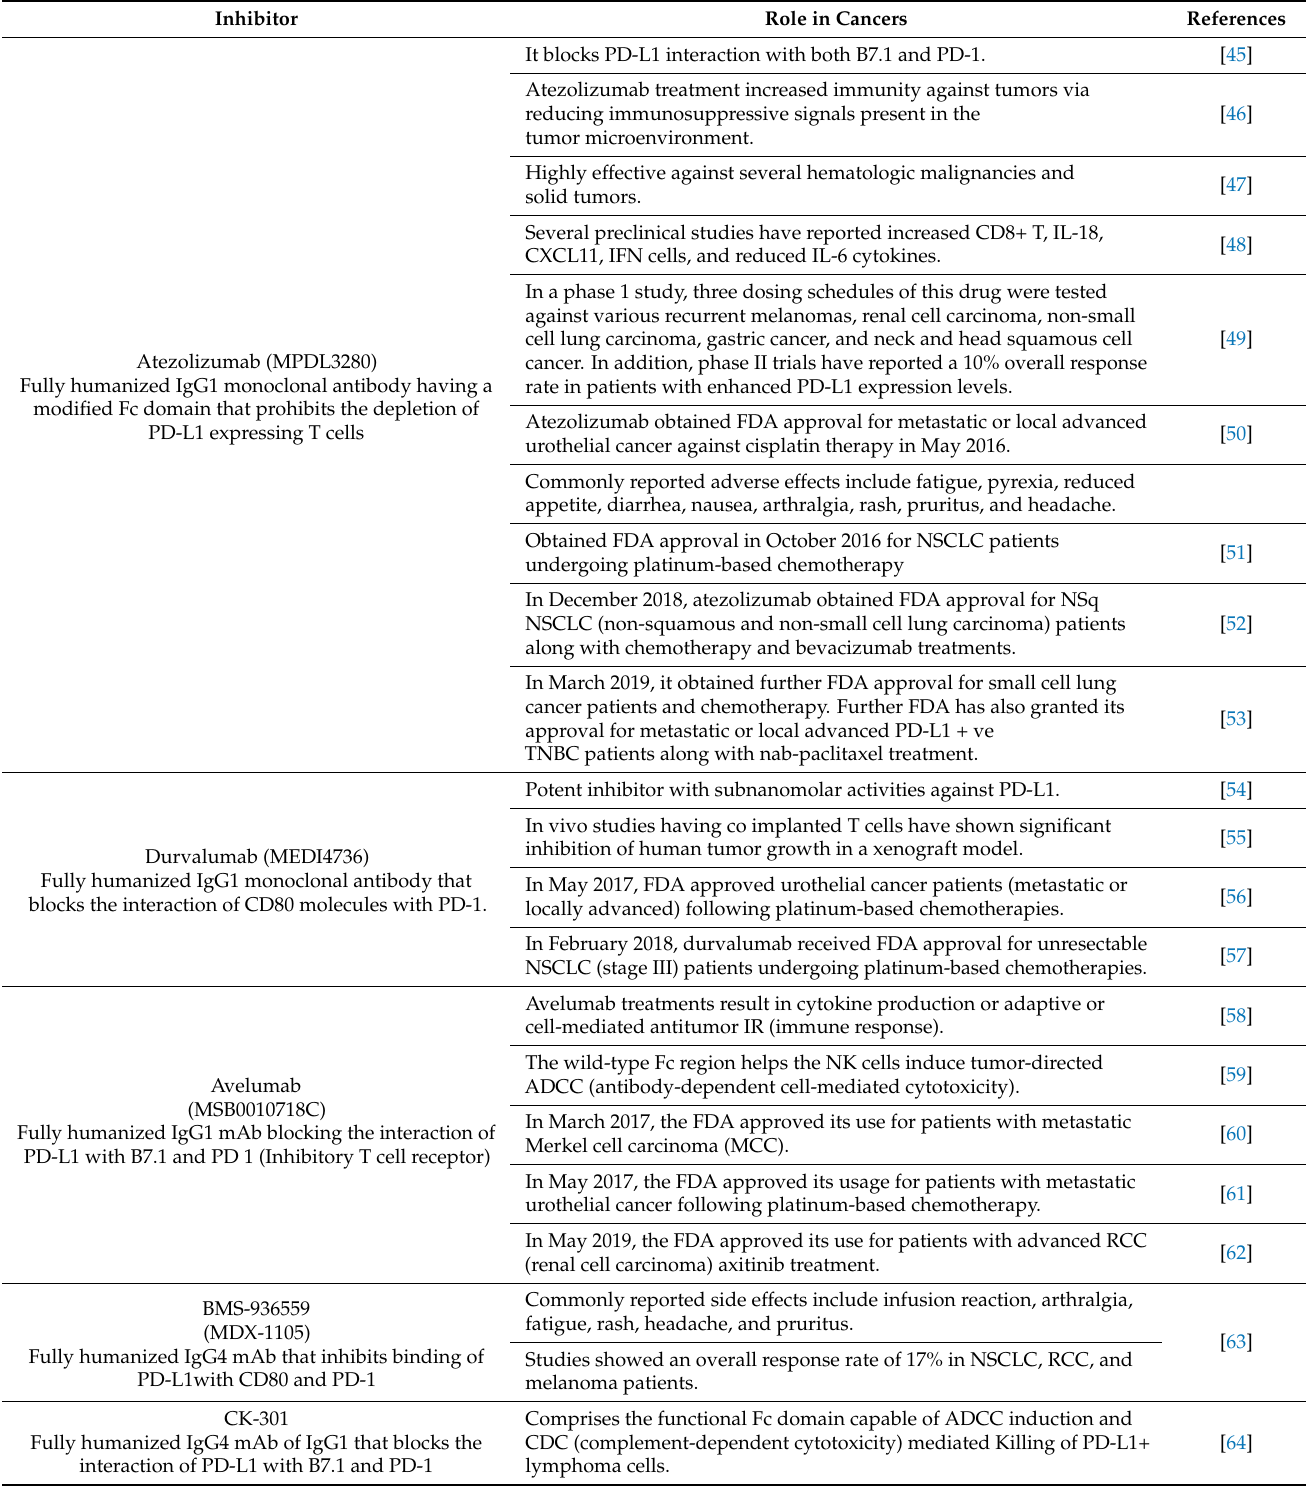
Table 3. Immune checkpoint inhibitors in cancer